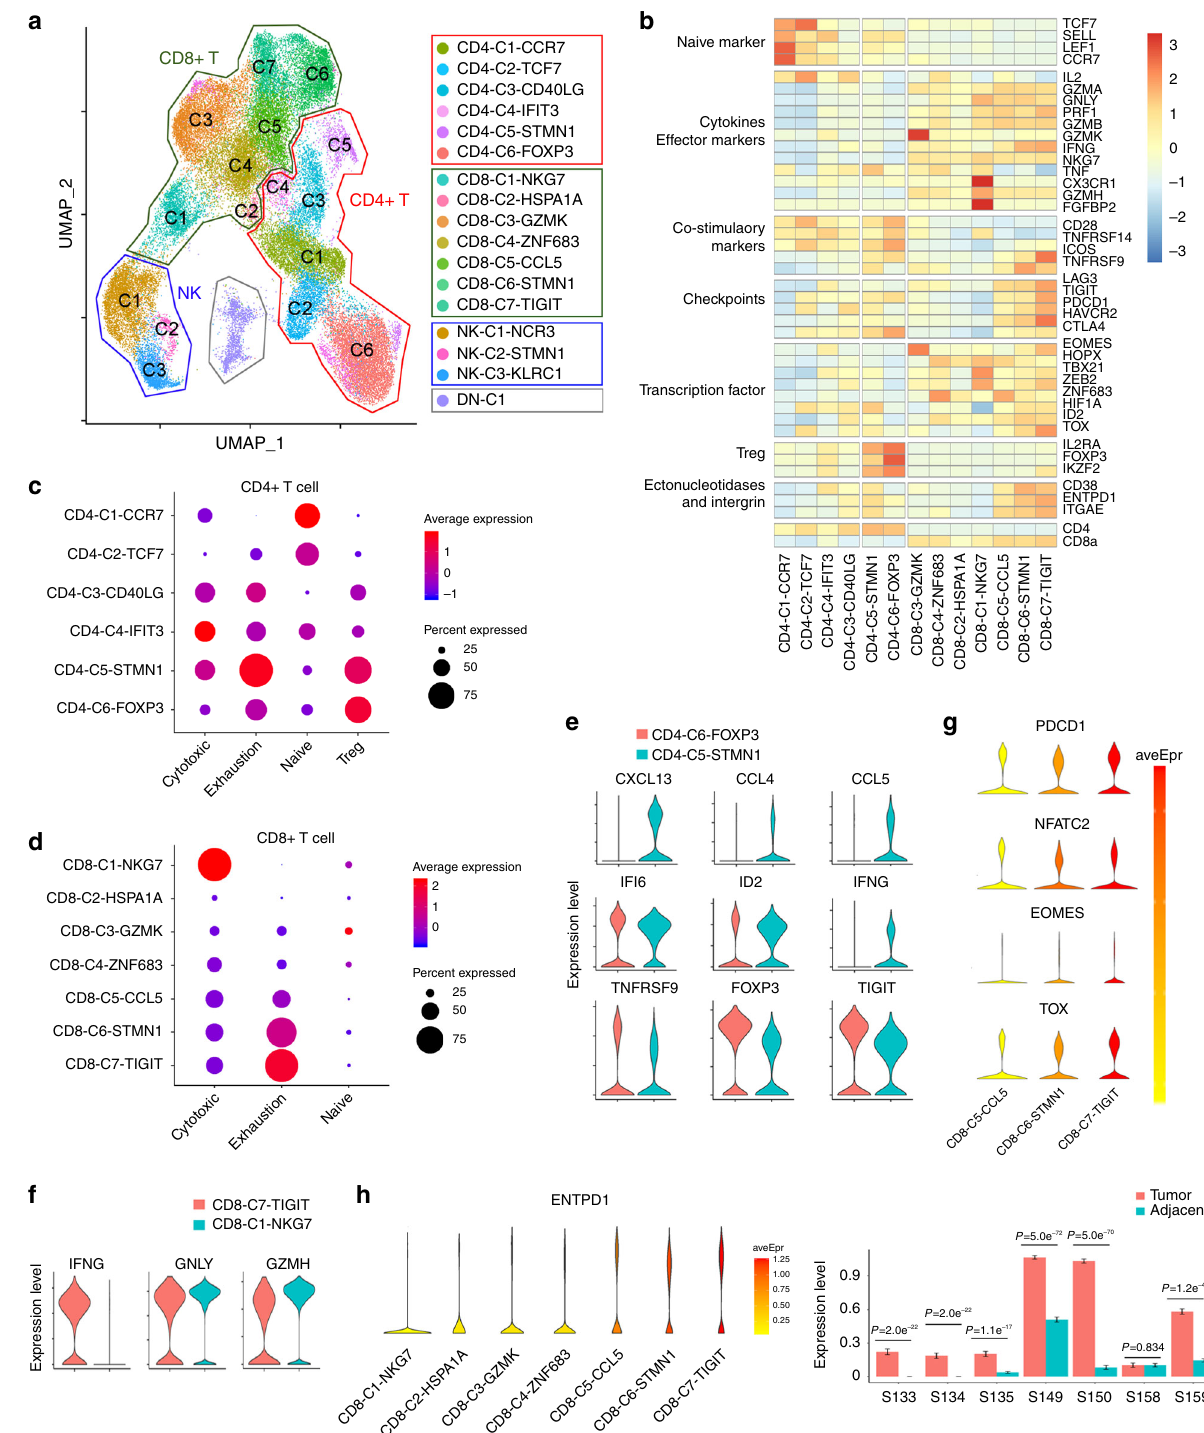
Fig. 2 Detailed characterization of T cells in ESCC. a UMAP plot of 44,634 single T and NK cells from 14 samples, showing the formation of 17 main clusters, including six for CD4 T cells, seven for CD8 T cells, one for CD4 and CD8 negative T cells cluster, and three for NK cells. Each dot corresponds to a single cell, colored according to the cell cluster. b Heatmap of Z -score normalized log2 (count + 1) expression of selected T cell function-associated genes in each cell cluster. c Dot plot of representative cytotoxic, exhaustive, naïve, and Treg signatures in CD4 T cell clusters, Z -score normalized log2 (count + 1). d Dot plot of representative cytotoxic, exhaustive, and naïve signatures in CD8 T cell clusters, Z -score normalized log2 (count + 1). e , f Violin plot showing the CXCL13 , CCL4 , CCL5 , IFI6 , ID2 , IFNG , TNFRSF9 , FOXP3 , and TIGIT in CD4-C6-FOXP3 and CD4-C5-STMN1 cells e IFNG , GNLY , and GZMH in CD8-C7- TIGIT and CD8-C1-NKG7 cells f . The expression was measured as the log2 (count + 1). g Violin plot showing PDCD1 , NFATC2 , EOMES , and TOX in the CD8- C5-CCL5, and CD8-C6-STMN1, CD8-C7-TIGIT clusters. The expression was measured as the log2 (count + 1). h Violin plot showing ENTPD1 expression in CD8 + T cell clusters from 7 paired ESCC and adjacent samples. The expression was measured as the log2 (count + 1). Data are presented as mean ± SD; P value was calculated by two-tailed Student ’ s t